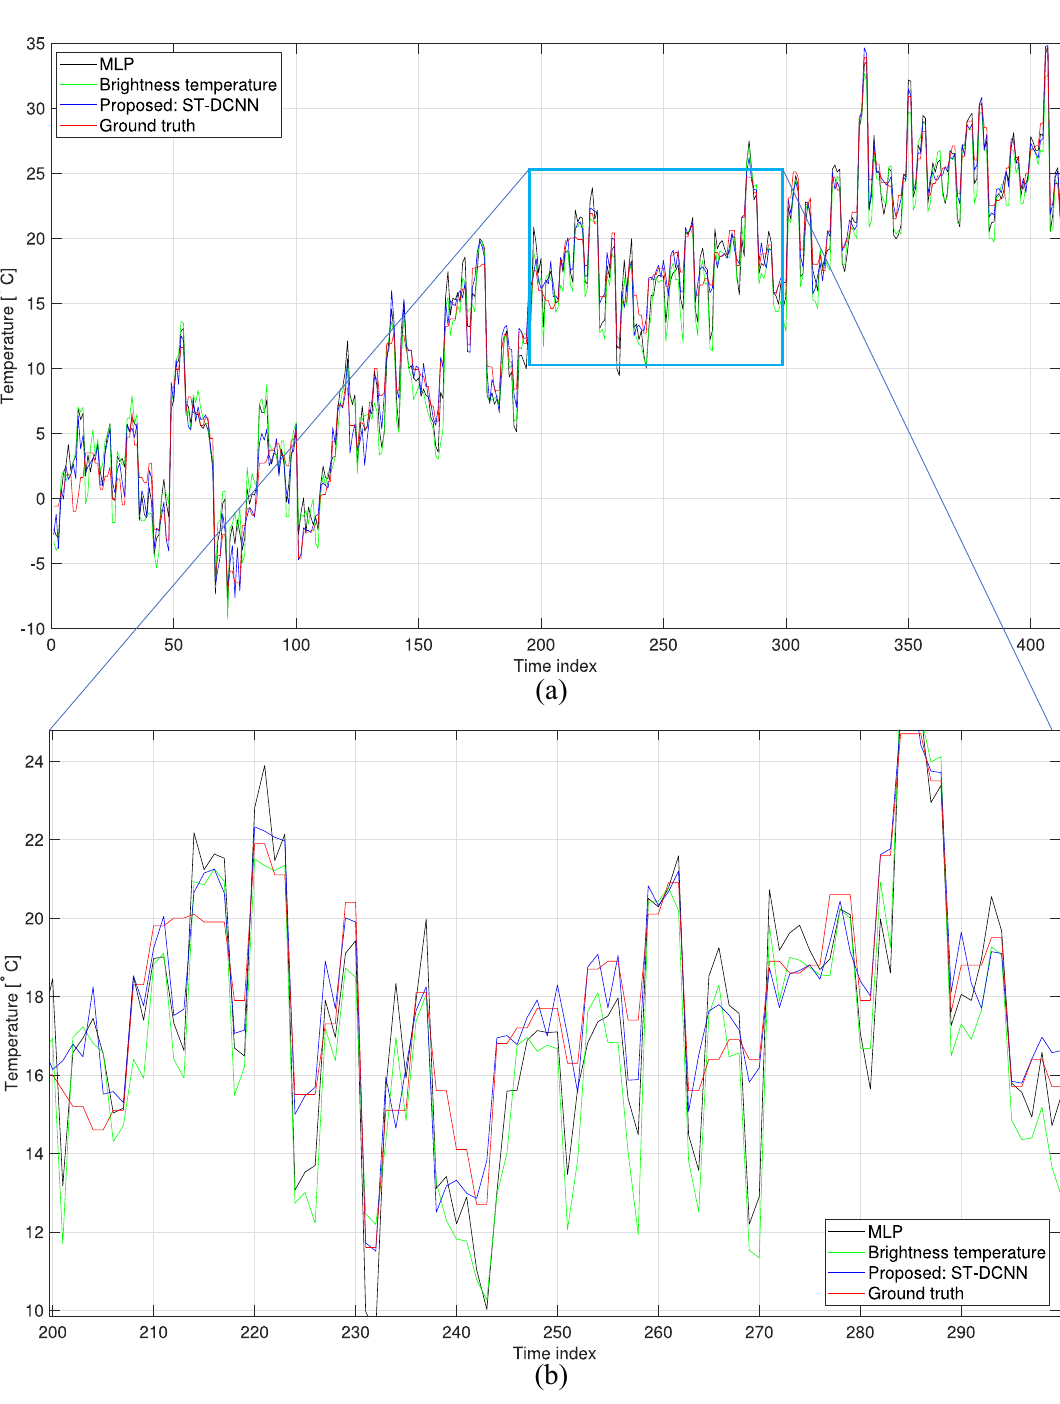
Figure 13. Comparison of the temperature estimation: ( a ) overall temperature; ( b ) enlarged view of the probe region. MLP: multi-layer